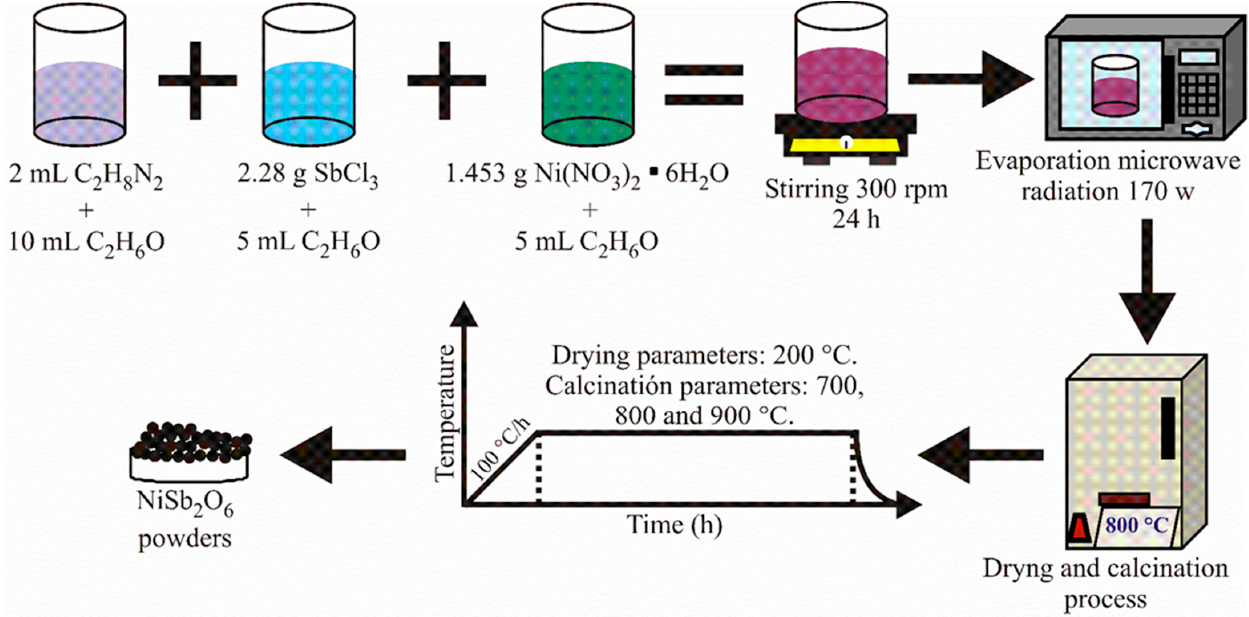
Figure 1. Synthesis process of NiSb 2 O 6 powders in air.